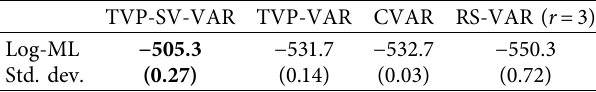
Table 9: Logarithmic marginal likelihood results of four types of VAR models.